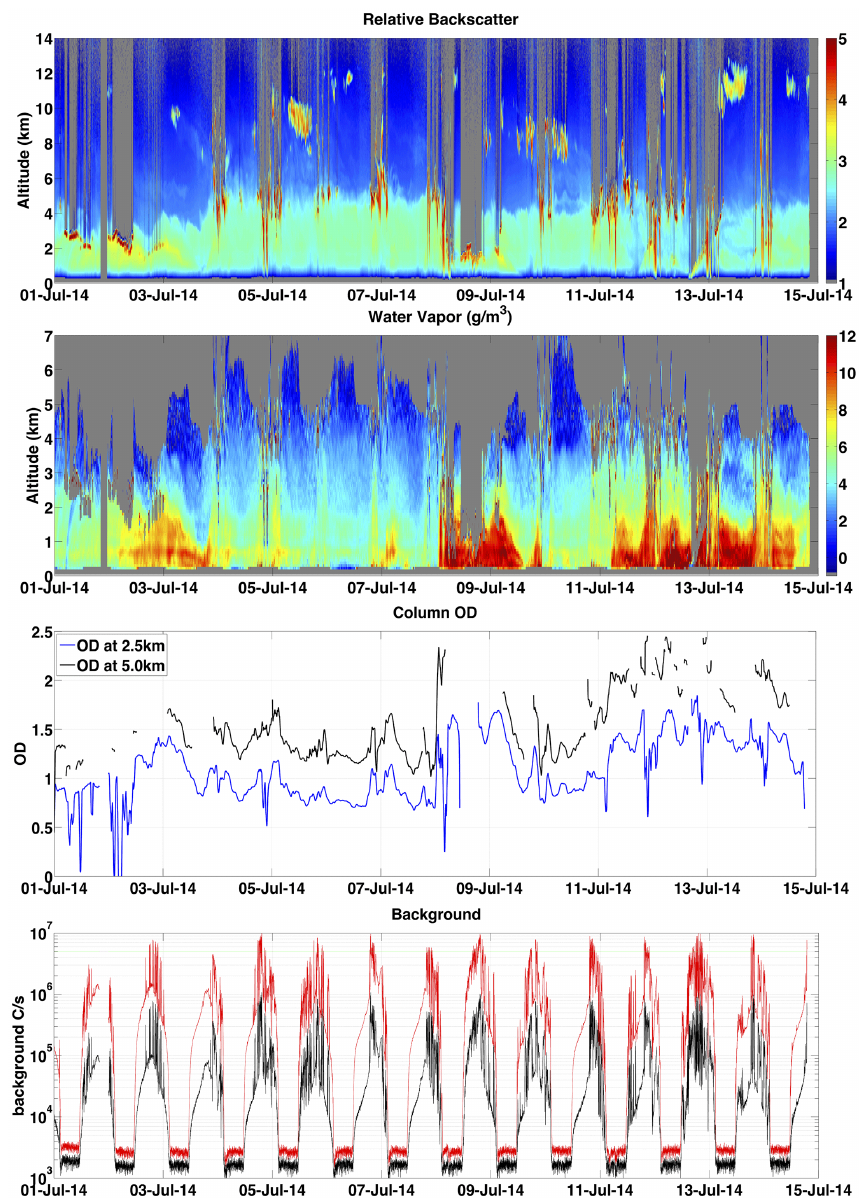
Figure 11. Two weeks of near continuous data collected 1–14 July 2014. Top panel: 1min, 150m resolution relative backscatter from 0 to 14km range for the far-range channel; second panel from top: 10min, 150m resolution water vapor in gm − 3 from 0 to 7km range for the far-range channel – with 300 and 600m smoothing applied to the data from 3 to 5.25km and above 5.25km, respectively, second panel from bottom: measured two-way optical depth at 2.5km (blue) and 5.0km (black) range for the far-range channel; and bottom panel: background in counts per second (Cs − 1 ) for the near-range (red) and far-range (black)